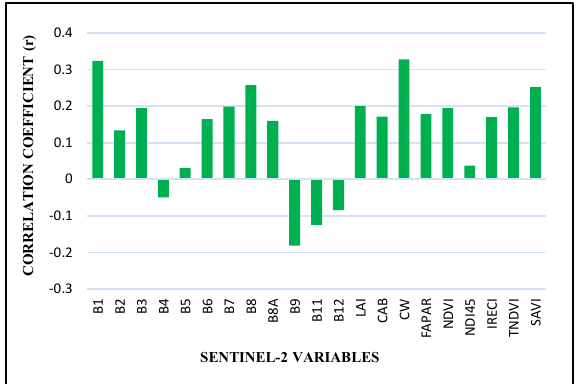
Figure 4. Correlation of Sentinel-2 predictor variables to field measured AGB.